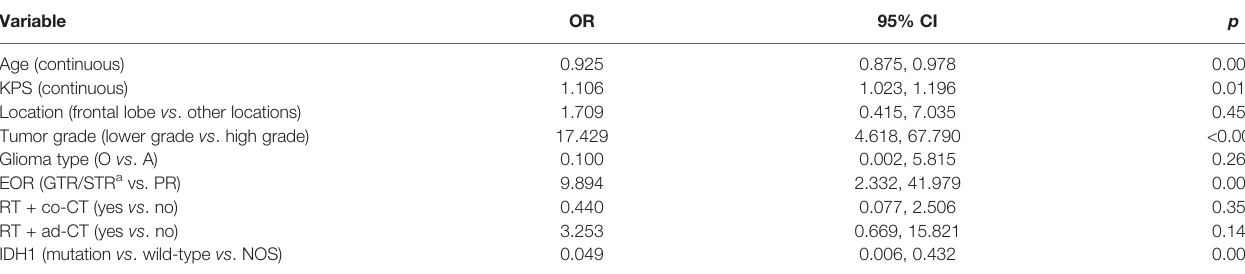
TABLE 2 | Multivariate analysis for statistically signi fi cant factors.